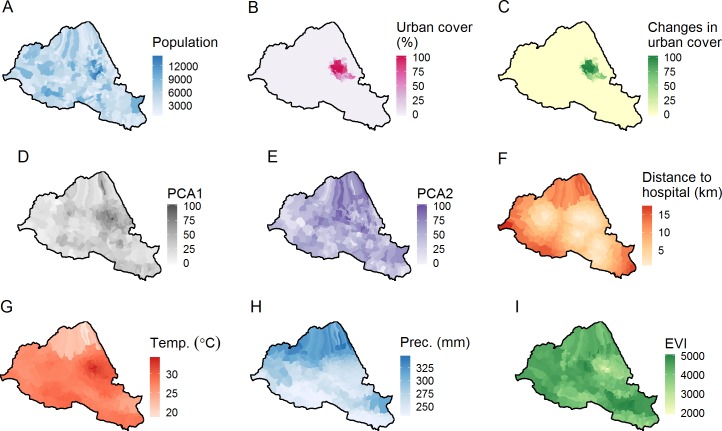
Dengue risk factors.(A) Total number of inhabitant in villages, as recorded in the Indonesian 2010 census. (B) Proportion of urban area in the village (%). (C) Changes in the proportion of urban area in the village (% per 10 years), as recorded by the difference in proportion of urban area between 2000 and 2010. (D) First socio-economic axis (PCA1), informing on the structure in employment type and education. (E) Second socio-economic axis (PCA2), informing on the age structure in each village. (F) Straight-line distance to the nearest hospital within the Regency (in km). (G) Mean average daytime temperature (°C), as recorded between March 2000 and December 2013. (H) Mean precipitation (mm per day), as recorded between January 1990 and December 2000. (I) Mean vegetation index (EVI), as recorded between February 2000 and December 2013.